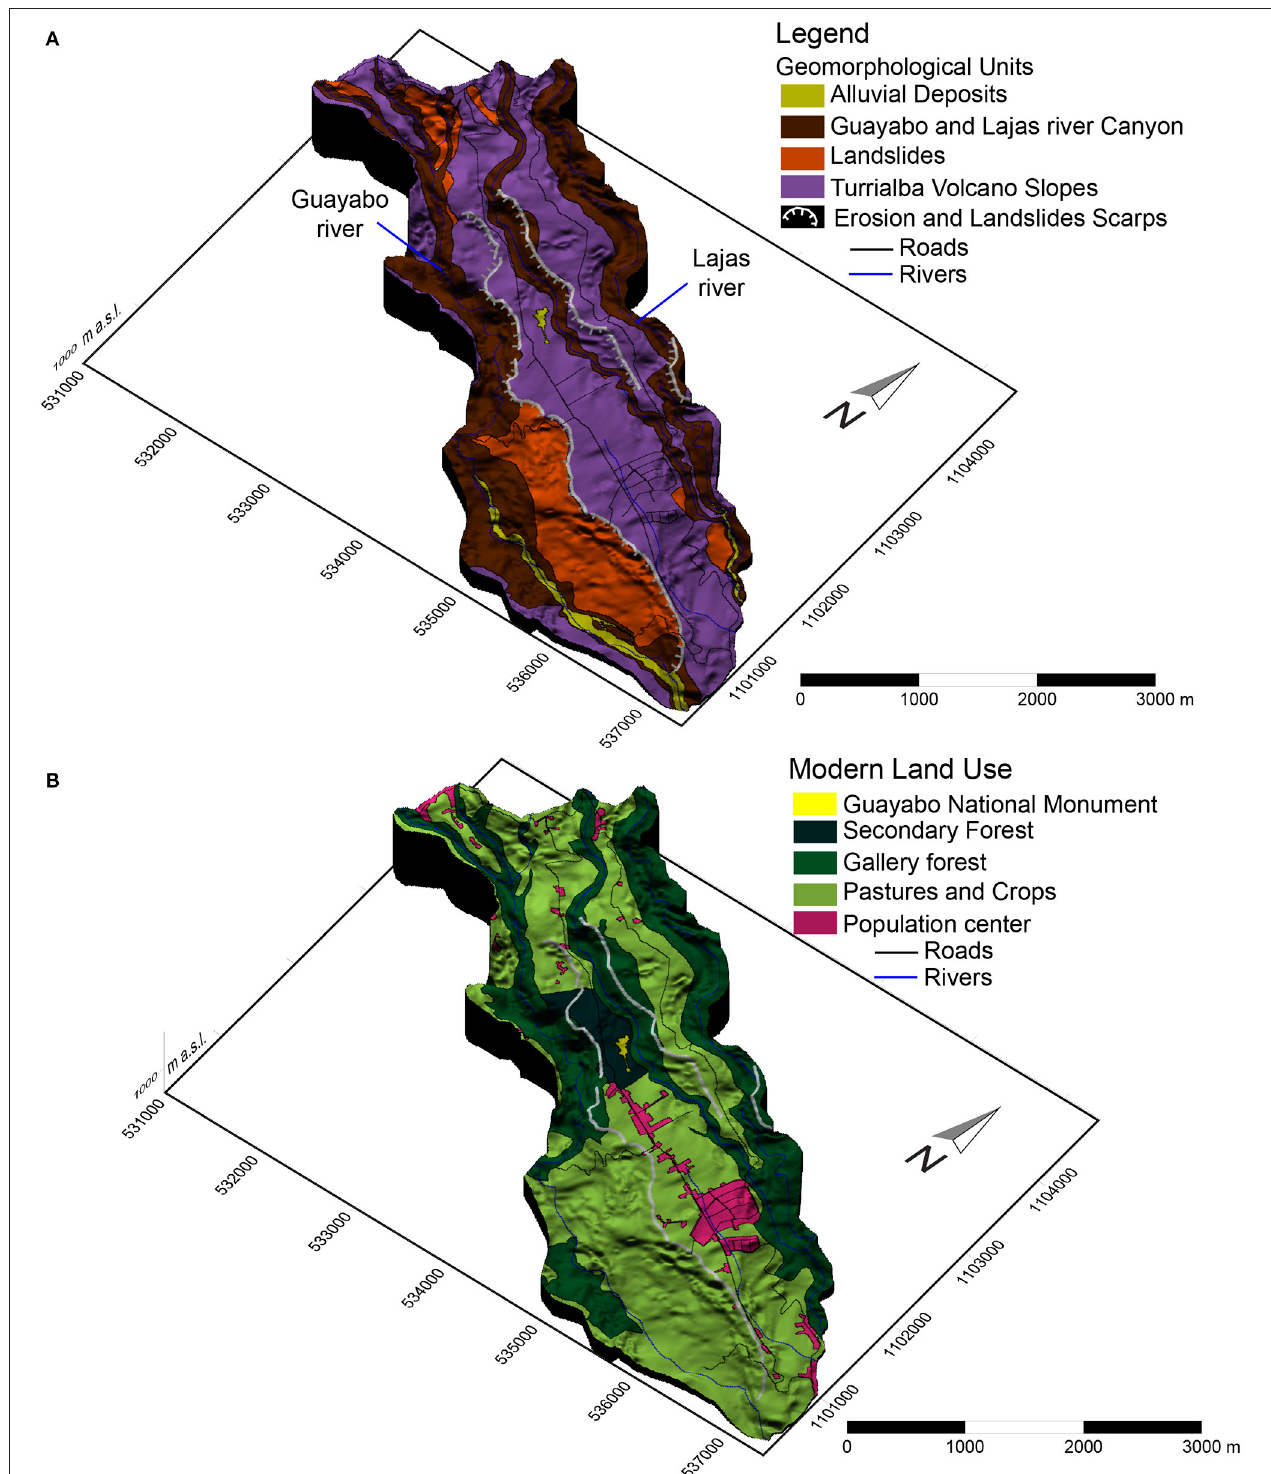
FIGURE 5 | (A) Geomorphological context in the area of the Guayabo National Monument, based on Obando and Peraldo, 2011 and our observations; (B) Modern land use distribution around the GNM.